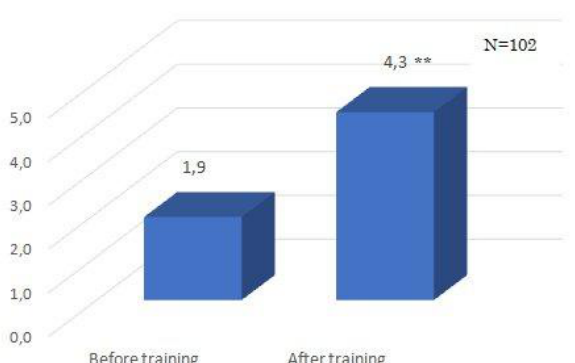
Figure 3: Practice level of activities for the prevention of dementia. Paired p-test, ** significant at 1% level.